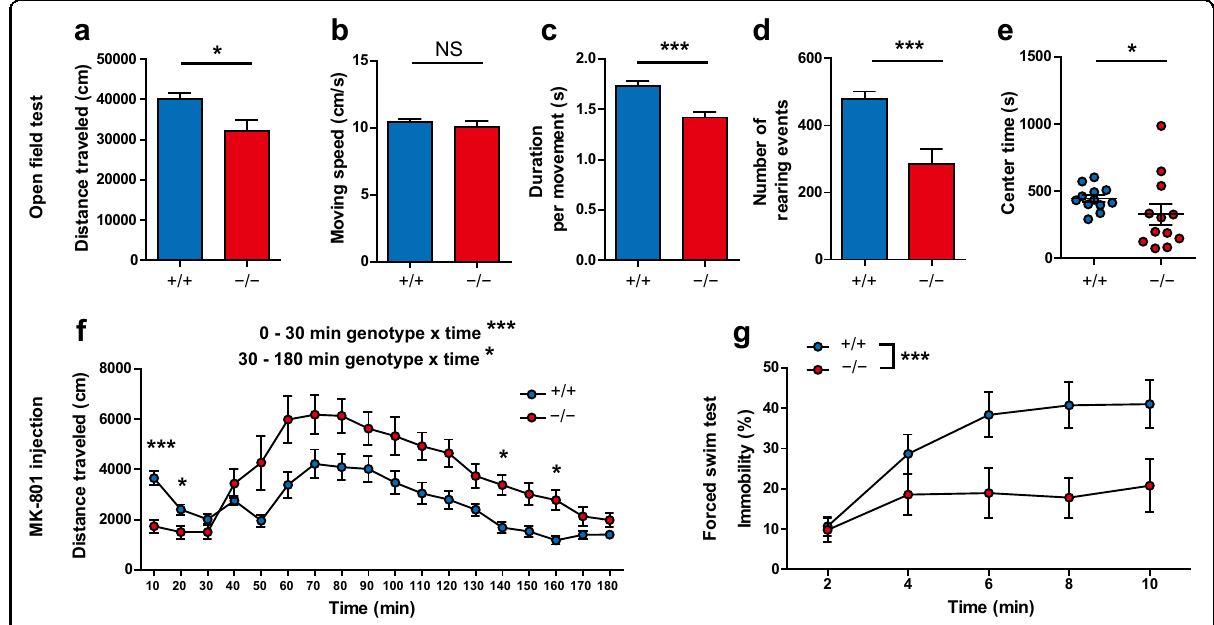
Fig. 3 Task-dependent alterations of activities in Gad1 − / − rats. a – e Open fi eld test ( n = 12 for each genotype). Gad1 − / − rats exhibited decreased distance traveled compared with Gad1 + / + ( t (16.051) = – 2.6272, p < 0.05) ( a ), but their moving speed was unaltered ( t (15.717) = − 0.6772, p = 0.5081) ( b ). Duration per movement ( t (21.82) = – 4.541, p < 0.001) ( c ) and number of rearing events ( t (16.456) = − 3.8561, p < 0.01) ( d ) were also decreased in Gad1 − / − rats, suggesting hypoactivity in the open fi eld. Gad1 − / − rats stayed less time in the center region ( W = 37, p < 0.05) ( e ). f Response to NMDA receptor antagonist ( Gad1 + / + , n = 12; Gad1 − / − , n = 11). Gad1 − / − rats showed hypoactivity at baseline (0 – 30min; genotype × time, F (2, 40) = 9.3185, p < 0.001) but showed enhanced hyperactivity after MK-801 injection (0.2 mg/kg, intraperitoneal injection) (30 – 180min; genotype × time, F (14, 280) = 1.9404, p < 0.05; simple main effect of genotype, adjusted by Holm ’ s method for multiple comparisons; 130 – 140min, p < 0.05; 150 – 160min, p < 0.05). g Forced swim test ( Gad1 + / + , n = 12; Gad1 − / − , n = 11). Gad1 − / − rats showed a signi fi cant decrease in immobility (genotype main effect, F (1, 20) = 6.4689, p < 0.05). The results are presented as the average ± SEM. The data were analyzed using the Wilcoxon rank-sum test ( e ), two-way repeated measures ANOVA ( f – h ), and Welch ’ s t -test (others). * p < 0.05, ** p < 0.01, *** p < 0.001; NS not signi fi